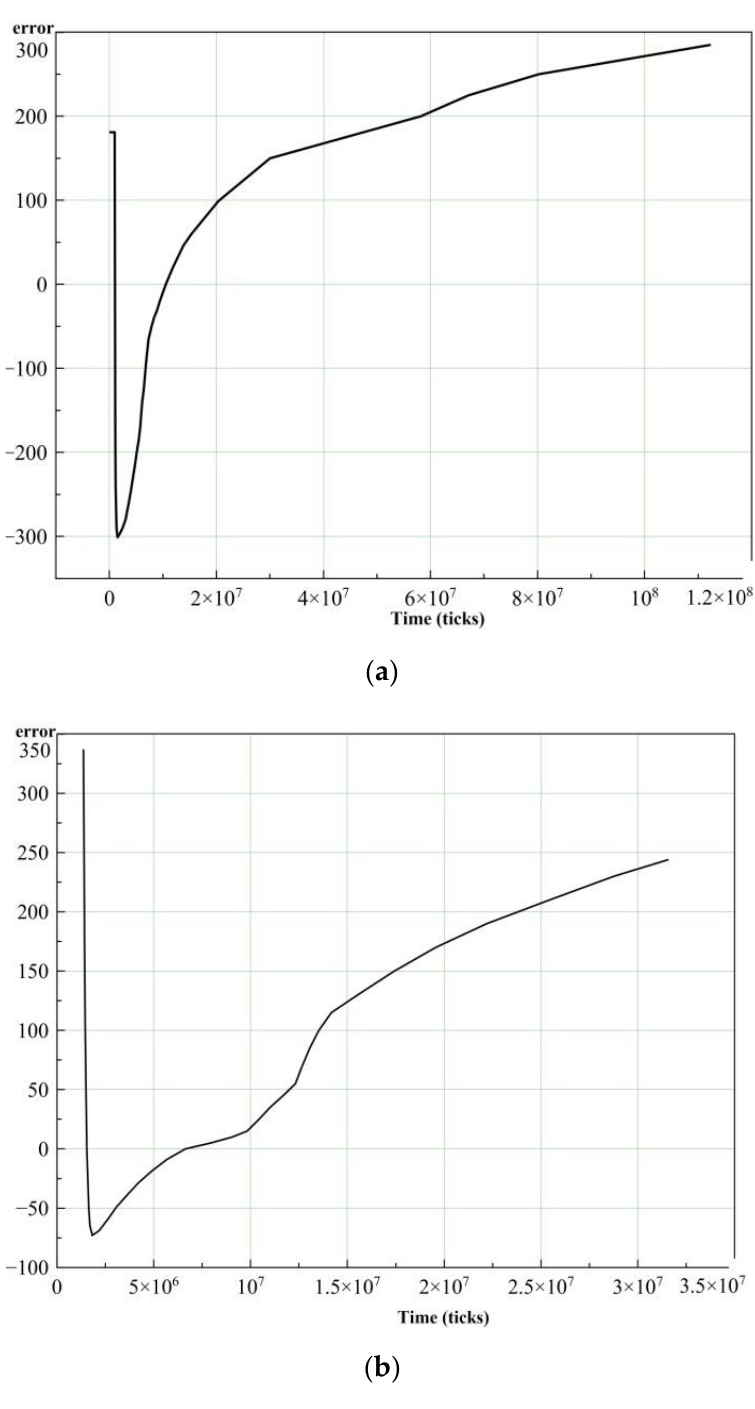
Figure 8. Desired signal amplitude (error) as a function of time (ticks) after filtration: ( a ) power consumption of 80%, ( b ) power consumption of90%.